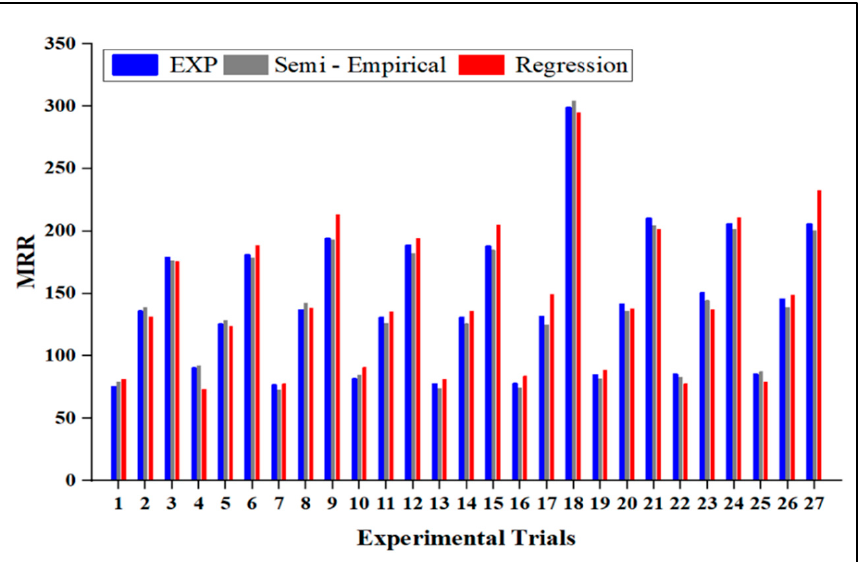
Figure 3. The MRR comparison between the experimental, semi-empirical, and regression meth- ods.